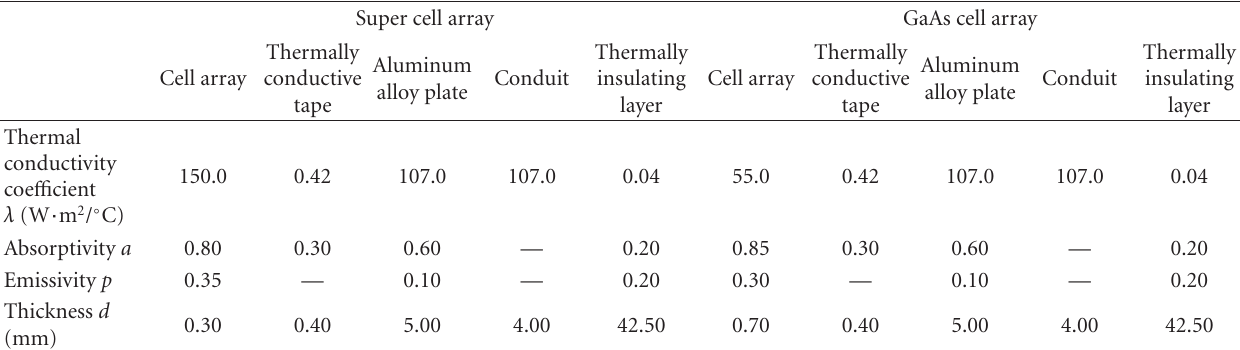
Table 1: Parameters of structure materials of the system.